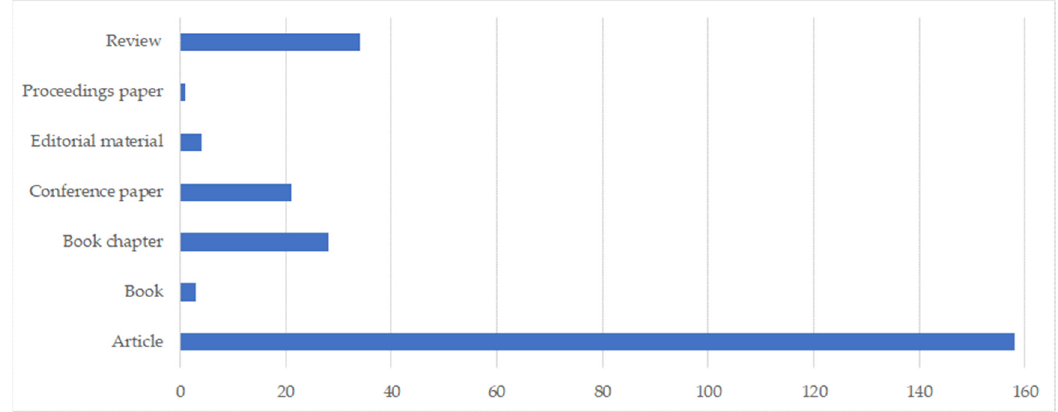
Figure 1. Number and type of documents retrieved and analyzed in the review study of climate-smart agriculture research in Africa.